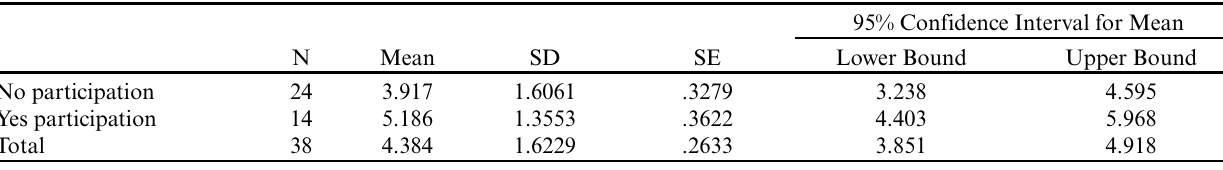
Table 1. ANOVA results for impact of participation in workshops on level of